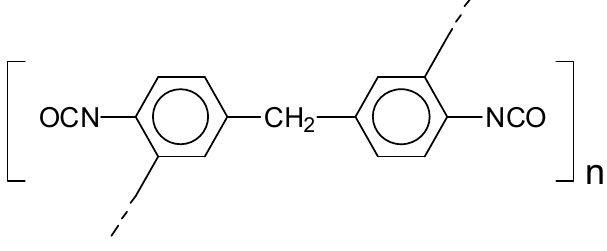
Scheme 5. Schematic representation of pMDI.